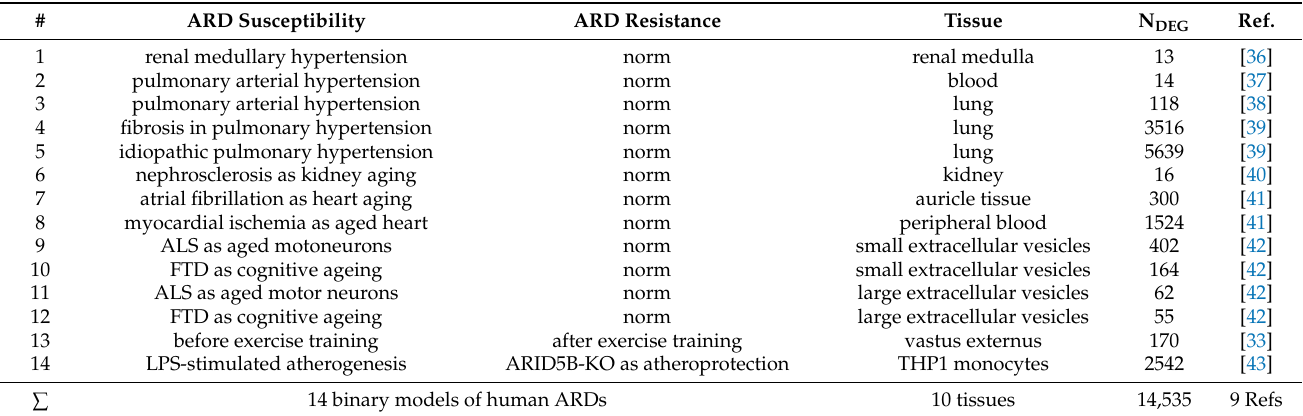
Table 5. DEGs in the binary “susceptibility versus resistance” models of human ARDs (PubMed data, [75]).